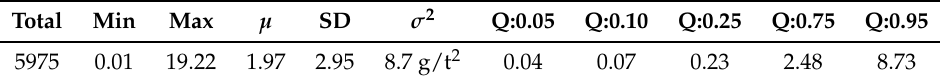
Table 2. Statistics reporting on numerical variables by quantiles in gold